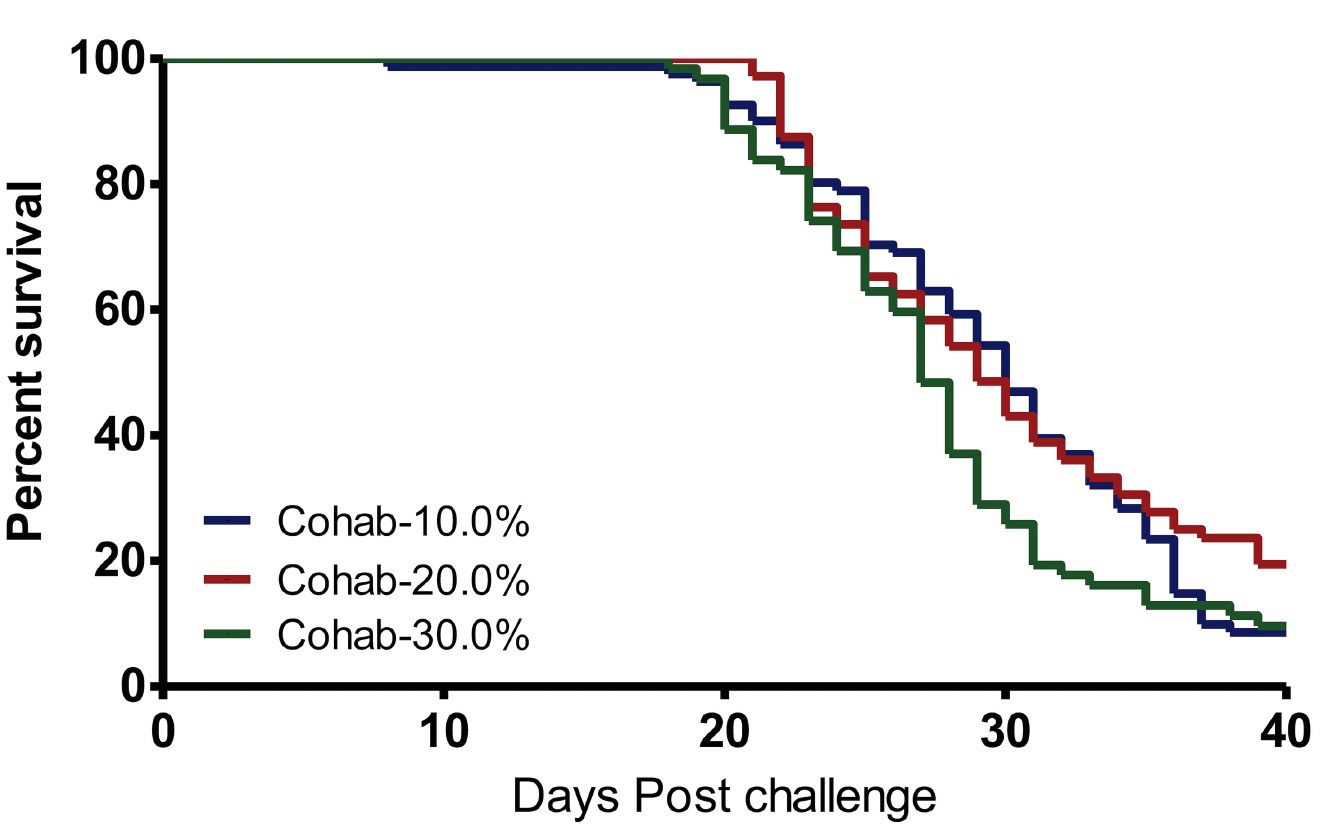
Fig 2. Proportion of virus shedders. KM survival analysis for cohabitees challenged with different (12.5%, 20% and 30%) proportions of virus shedders of the total number of fish per tank ( N = 90; Study III). All virus shedders were injected with 1x10 7 TCID 50 /fish with strain NVI015-TA. Mortality of shedders in the 10% and 30% proportion groups started on day 18 after challenge while for the 20% group day 21 after challenge was the first day of mortality. Overlaps in the KM survival curves for the cohabitees show that there was no statistical difference between the 10% and 20% (p > 0.368), as well as between the 10% and 30% (p > 0.1051) proportion of virus shedders of the total number of fish per